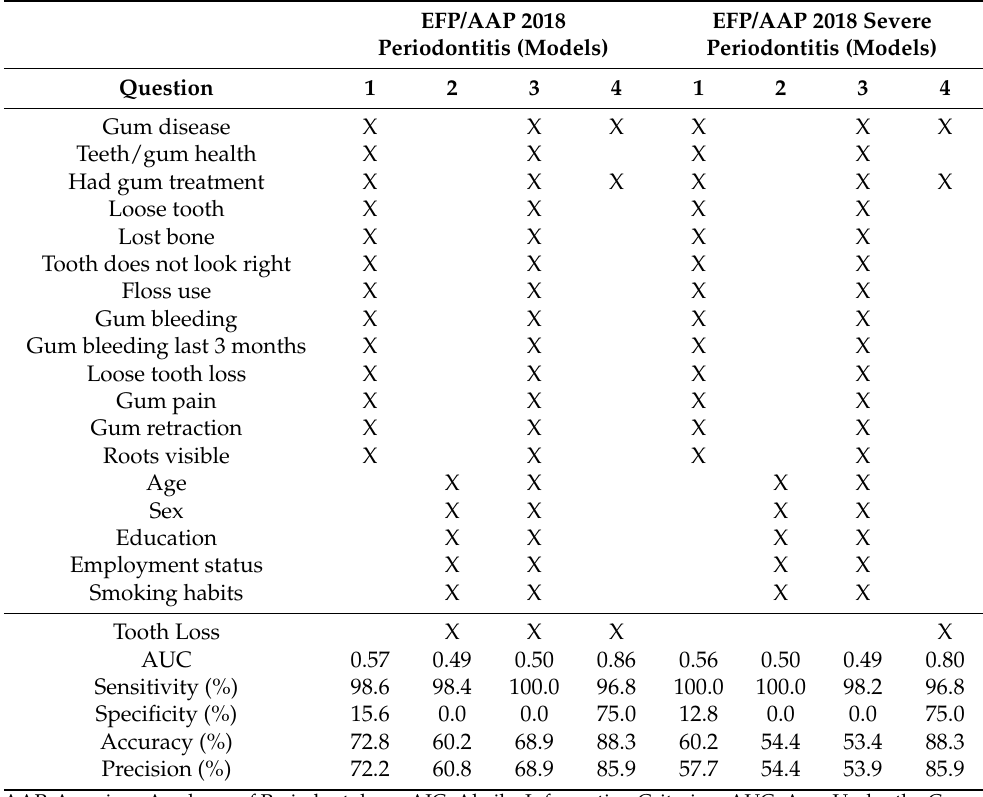
Table 5. Logistic regression models for the periodontitis CDC/AAP case definition of 2012 and respective performance